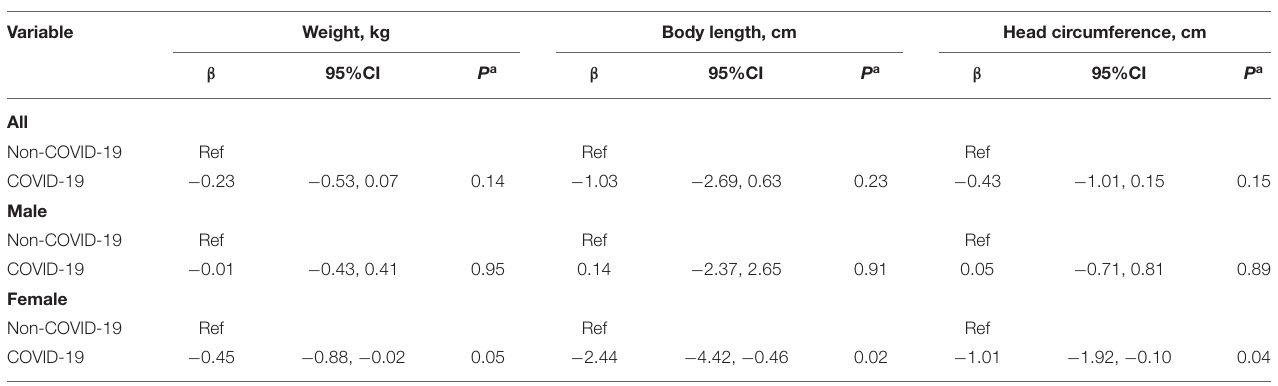
TABLE 3 | Linear mixed-effect models predicting physical development of infants.